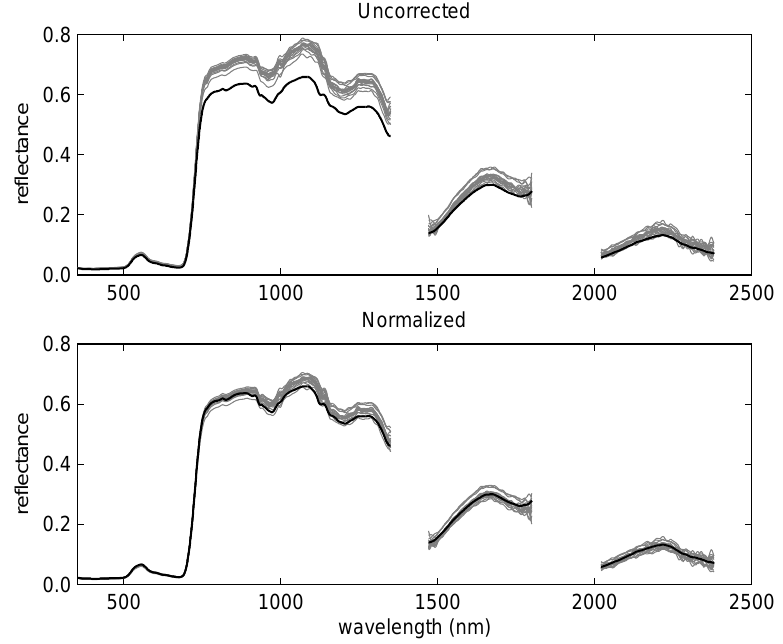
Figure 9. Reflectance factor of Citrus trees measured under obscured conditions (grey lines, individual scans) with a reference (black line, average value) measured under unobscured conditions. Top figure: uncorrected spectra. Bottom figure: after multiplication with a normalization